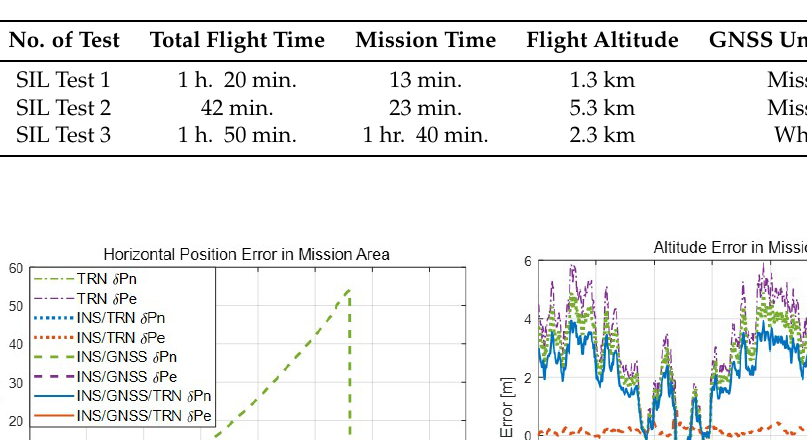
Figure 7. Trajectories for SIL tests. Table 1. Simulation conditions of the SIL tests.